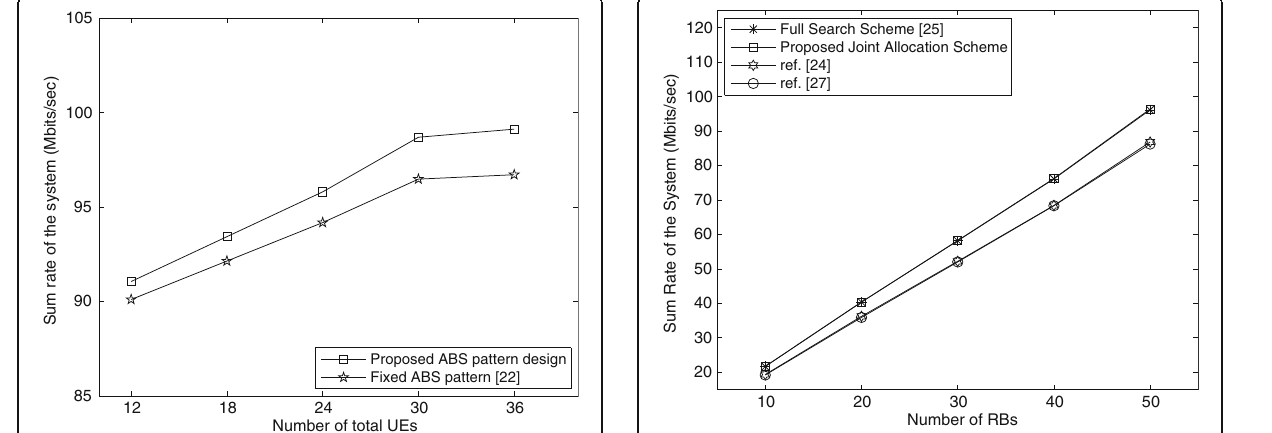
Fig. 4 Comparison of the proposed ABS pattern design with the fixed ABS pattern. The sum rate of the system versus the number of UEs with the number of RBs N = 50 and the bias value = 8 dB